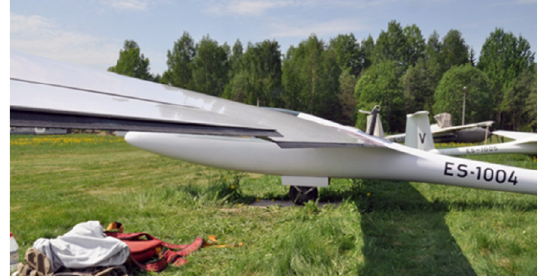
Fig. 2. Jantar-Standard 3 with the fixed 2% chord length miniflaps (Photo: K-E.